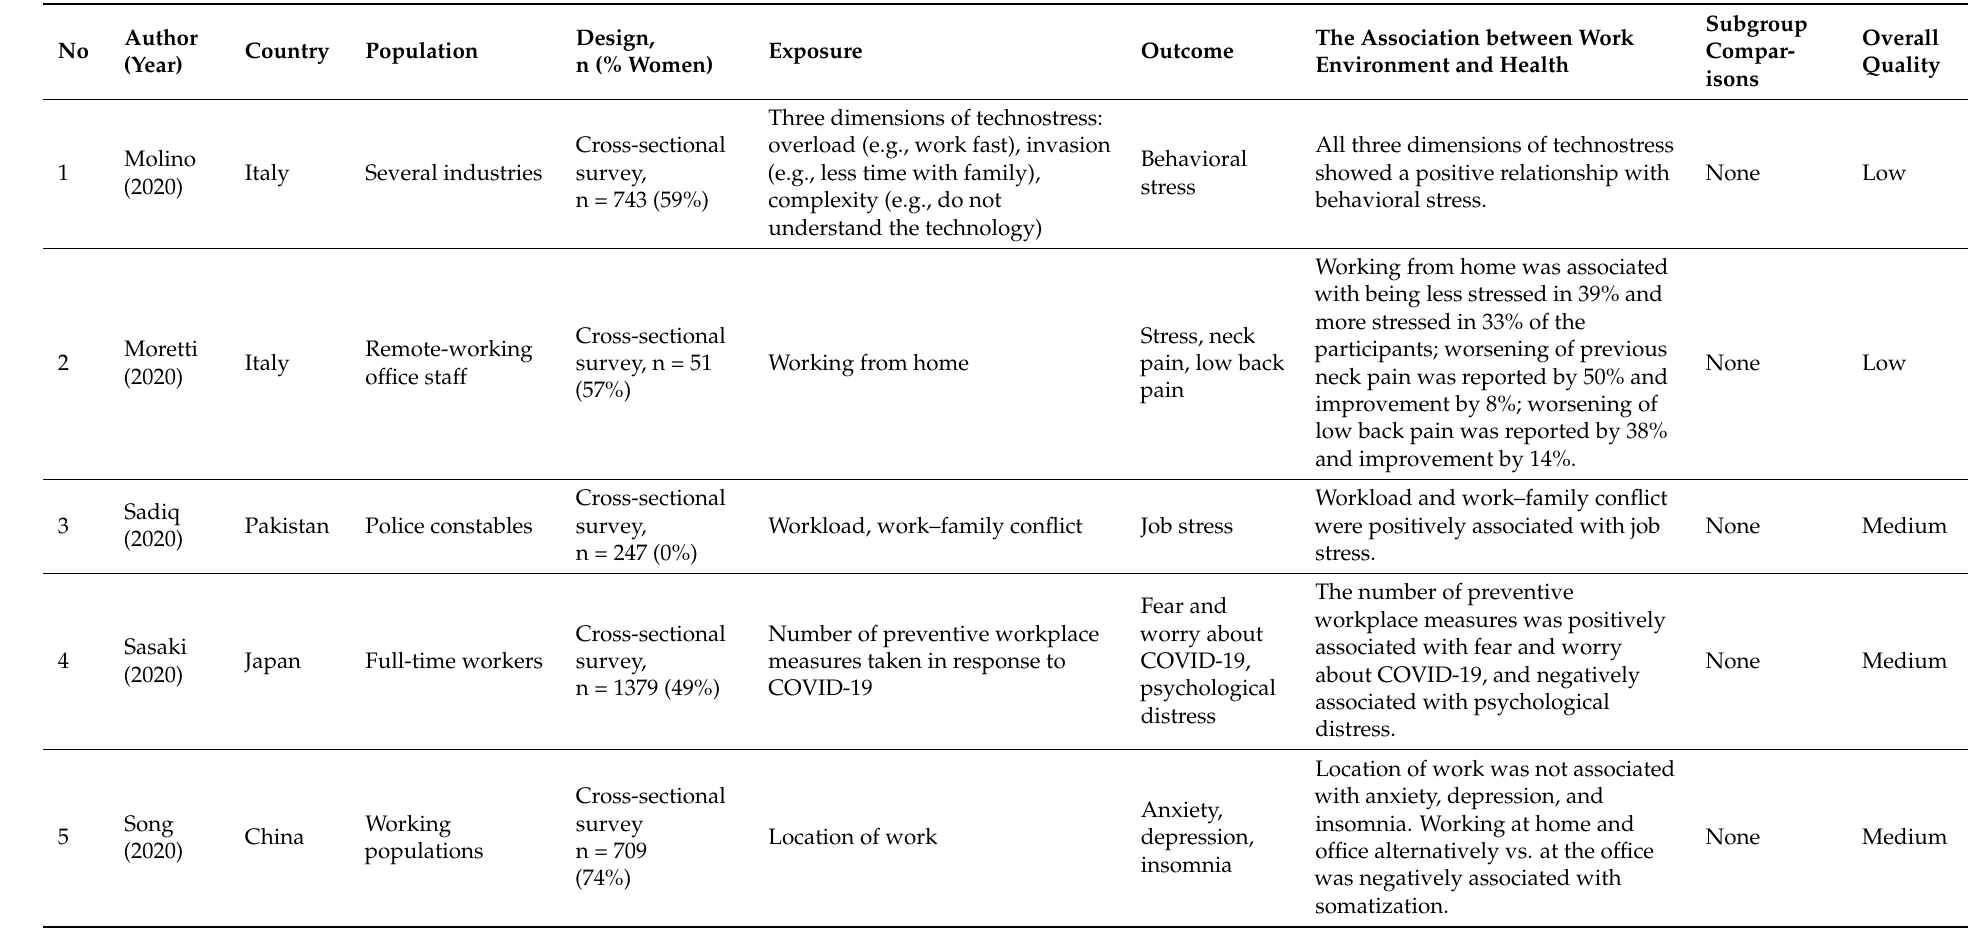
Table 6. Overview of quantitative studies assessing the associations between work environment factors and health in organizations outside the healthcare